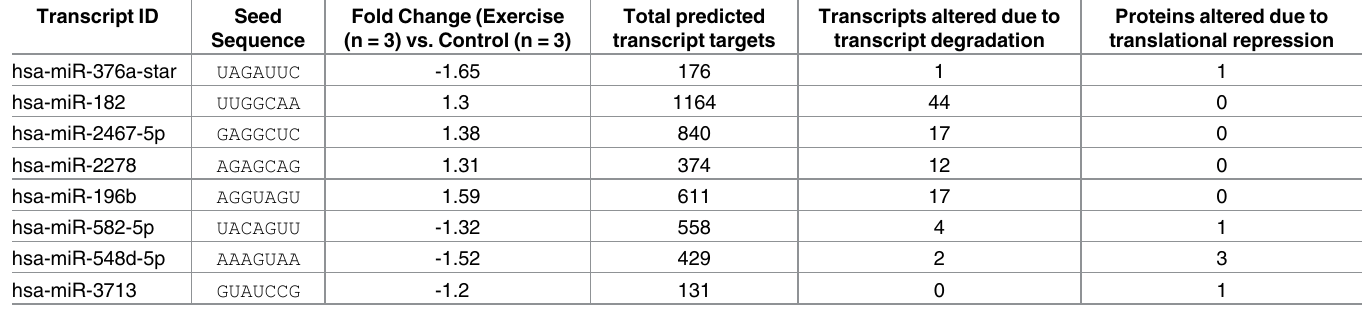
Table 2. Overview of microRNA expressionpairing with mRNA and proteomic data sets.